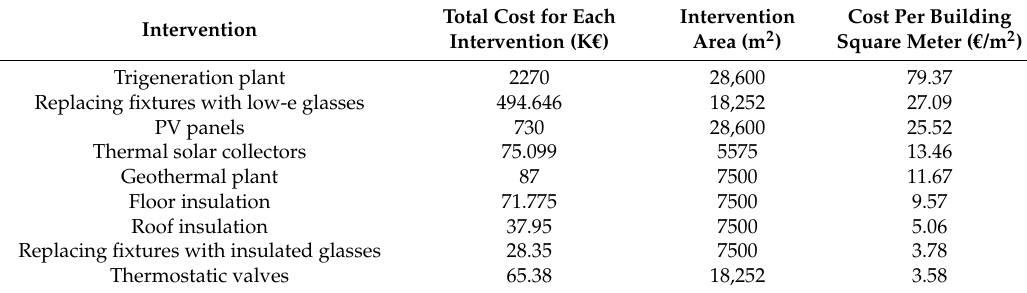
Table 14. Economic costs for each considered intervention.